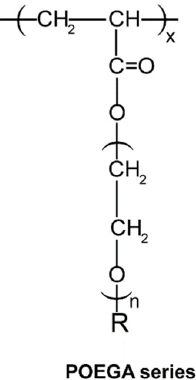
Figure 1. Structure of Poly( oligo (ethylene glycol) Alkyl Ether Acrylate) gel series (R = Me or Et; n = 2, 3, or